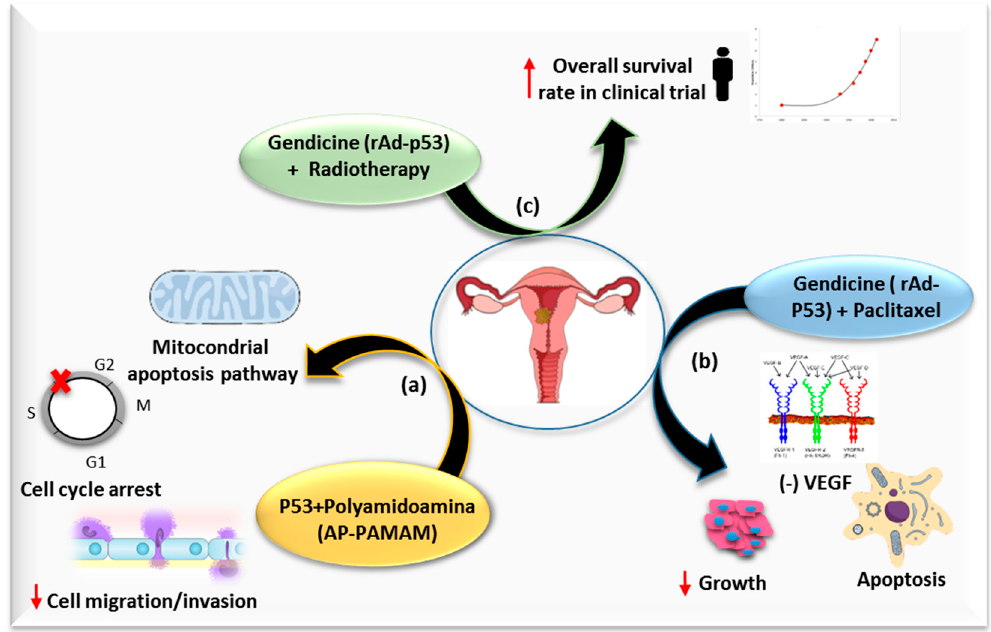
Figure 2. Schematic representation of some strategies focused on p53 restoration in cervical cancer developed to be used alone ( a ) or in combination with ( b ) chemotherapy or ( c ) RT.